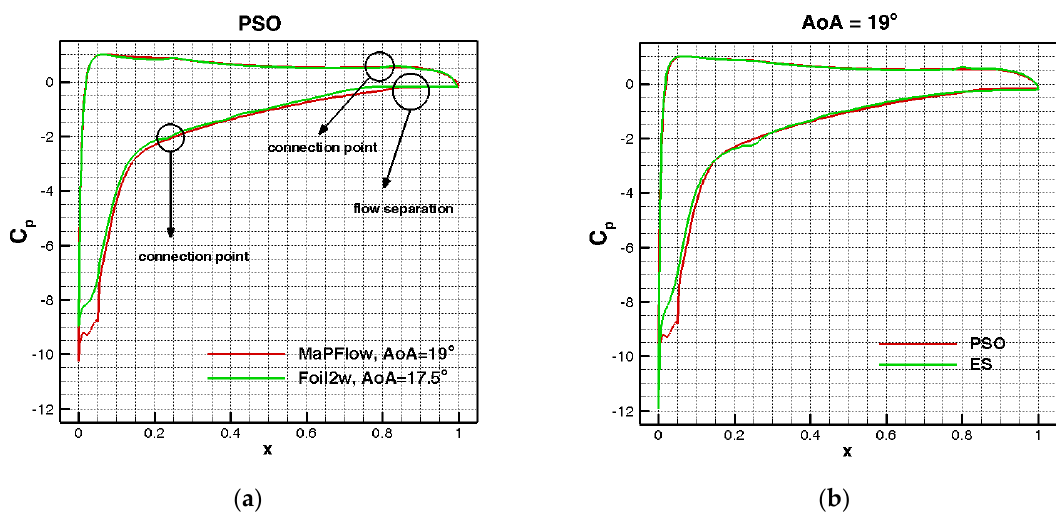
Figure 16. ( a ) Comparison between C p distributions along PSO-airfoil, simulated by Foi2w and MaPFlow, at the maximum C L angles of attack;( b ) C p distribution along the PSO and ES airfoils, simulated by MaPFlow, at the maximum C L angle of attack .